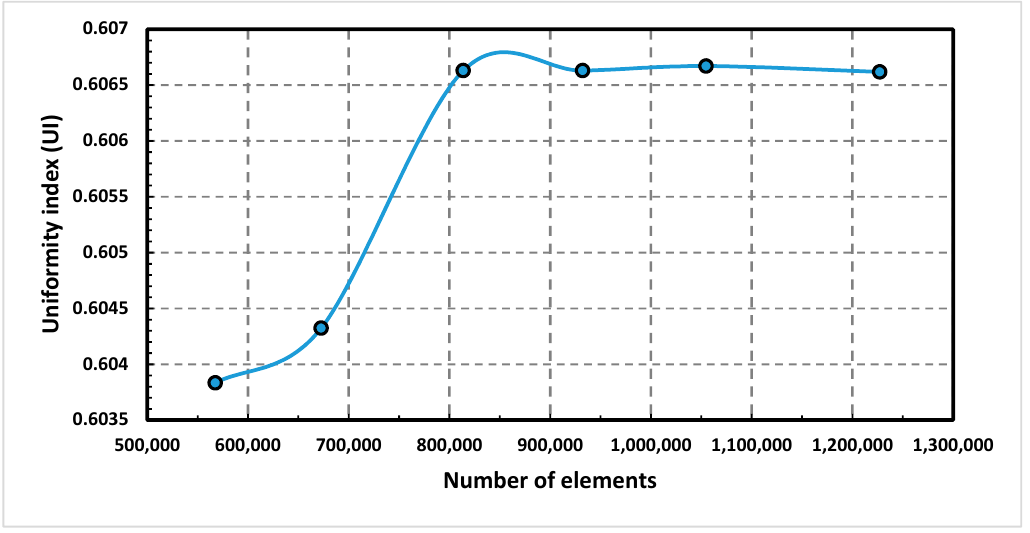
Figure 9. Uniformity index at mixer outlet (model 1), grid independence test results.